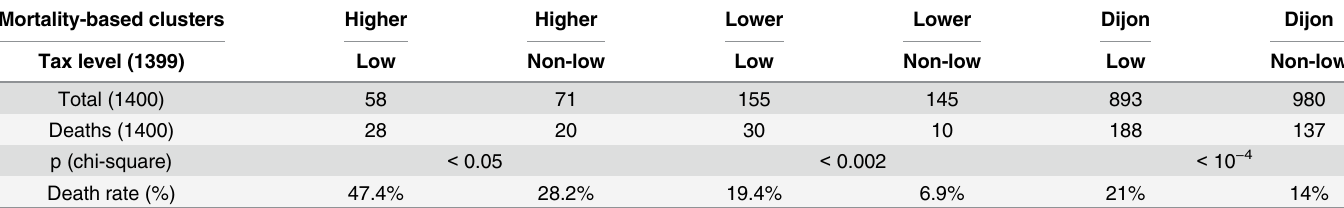
Table 4. Deaths (in 1400) of low-tax payers and non-low-tax payers of 1399. Mortality-based